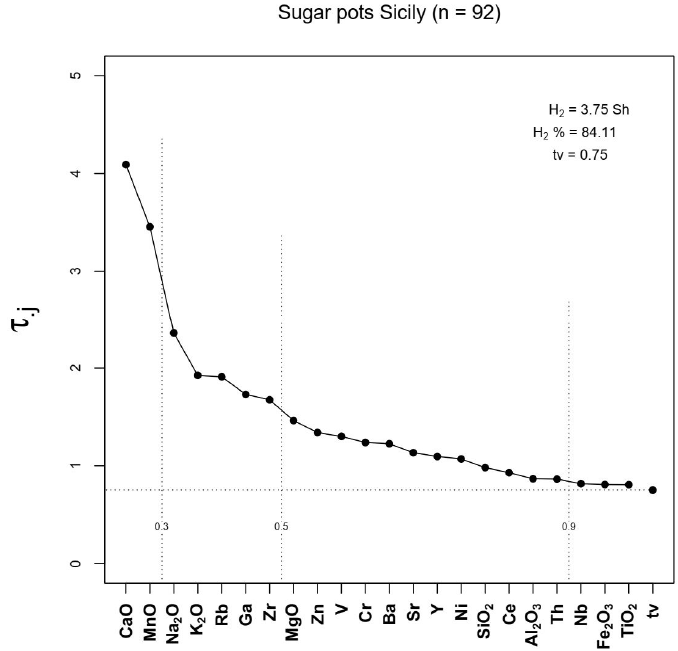
Figure 4. Compositional evenness graph of all the measured individuals according to the entropy value (H 2 and its relative value from the maximum attainable, H 2 %) of the elements considered for the statistical treatment of data. tv = total variation. τ . j : trace of the variance-covariance matrix following the alr transformation using that j element as the divisor. Vertical dotted lines express different tv/ τ . j values.